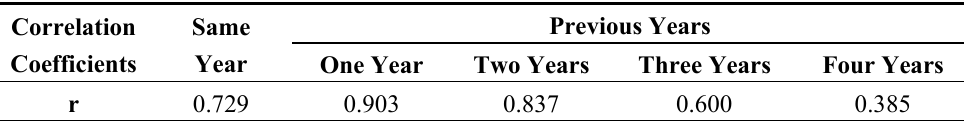
Table 4. Correlation coefficients between SINDVI values and runoff at the Langxinshan hydrological station.